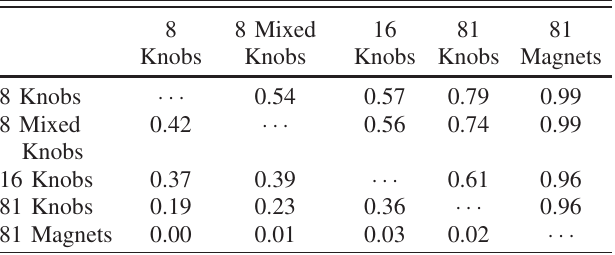
TABLE IV. Comparison of genetic algorithms with different genes in a larger search space. The fraction of trials (out of 179) where the individuals found by the genetic algorithm running with the genes listed on the left comprise the majority of the joint nondominated front when its final population is combined with the final population of the algorithm running with the genes listed above. Higher numbers indicate better performance by the genes to the left and poorer performance by the genes above. The search range for each gene has been increased by a factor of 10 from what was used to obtain Table III. In this case, the reduction in the number of dimensions plays a significant role in improving the algorithm performance.